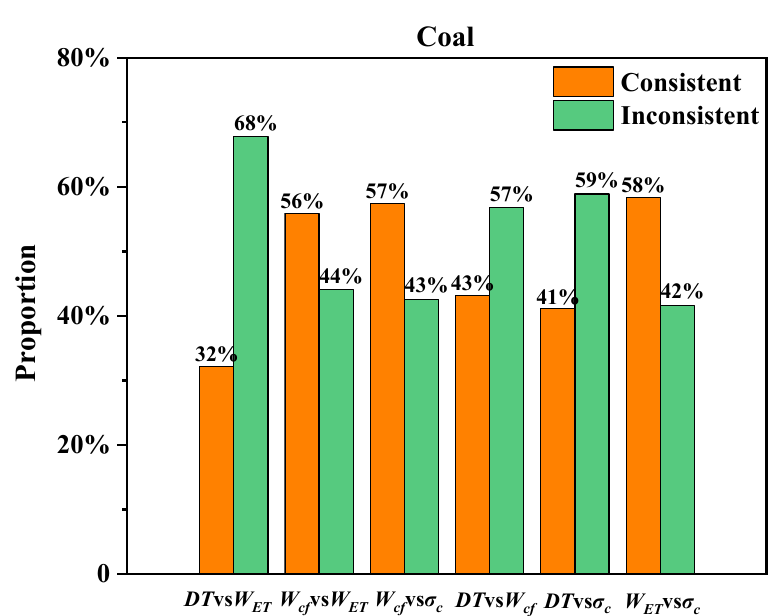
Figure 9. Consistency and inconsistency proportions of bursting liability evaluation results of coals using different indices.